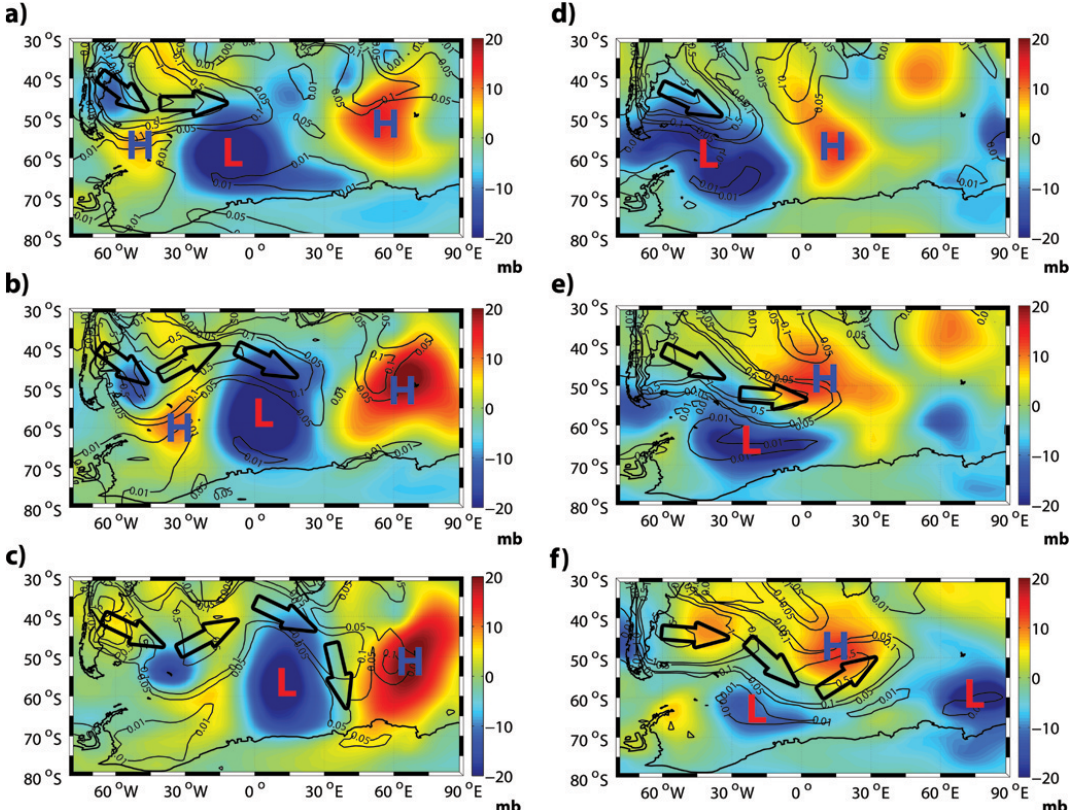
Fig. 6. GEOS-Chem-predicted dust burden (gm − 2 ) (contour lines) and sea level pressure anomalies (SLPAs) (mb) over the SAO for (a–c) 23–25 January 2009 and (d–f) 13–15 February 2009. Arrows are for the visual aid for the general transport pathway of Patagonian dust. Low and high pressure anomalies are shown by symbols of L and H , respectively.